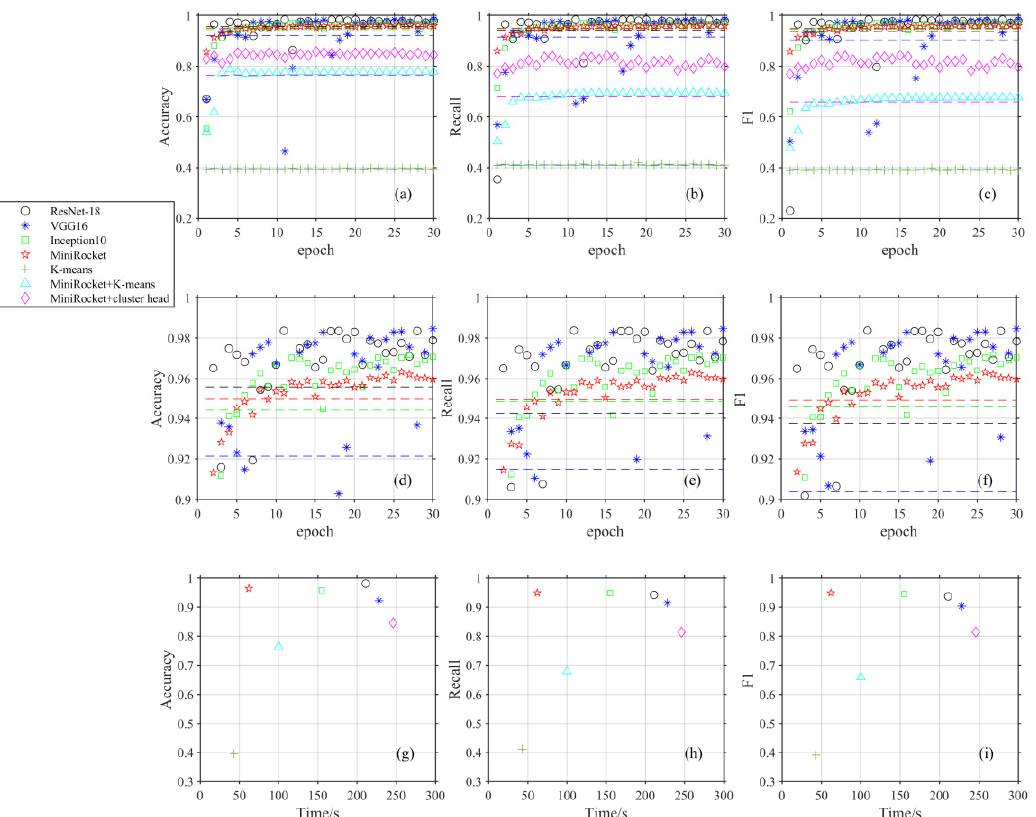
Figure 3. Epoch calculation accuracy, recall, and F1 values with calculation time of 30 times with all classification methods. ( a – c ) Comparative accuracy, recall, and F1 values for different models in each epoch; the dotted line indicates the average value. ( d – f ) The enlarged images of ( a – c ), respectively, show only the exponential distribution in the range of 0.9–1 in order to clearly see the indexes of various methods. ( g – i ) Comparison of the calculation efficiency and the mean accuracy, recall, and F1 values of different models.